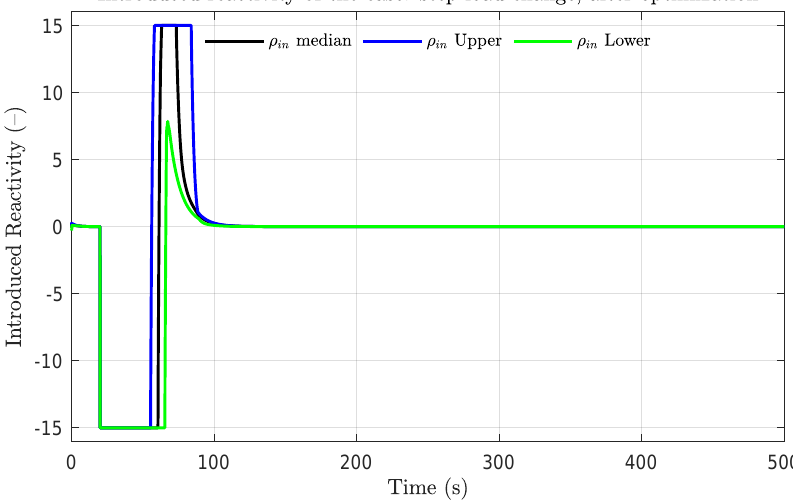
Figure 16. Introduced reactivity of the case of step load